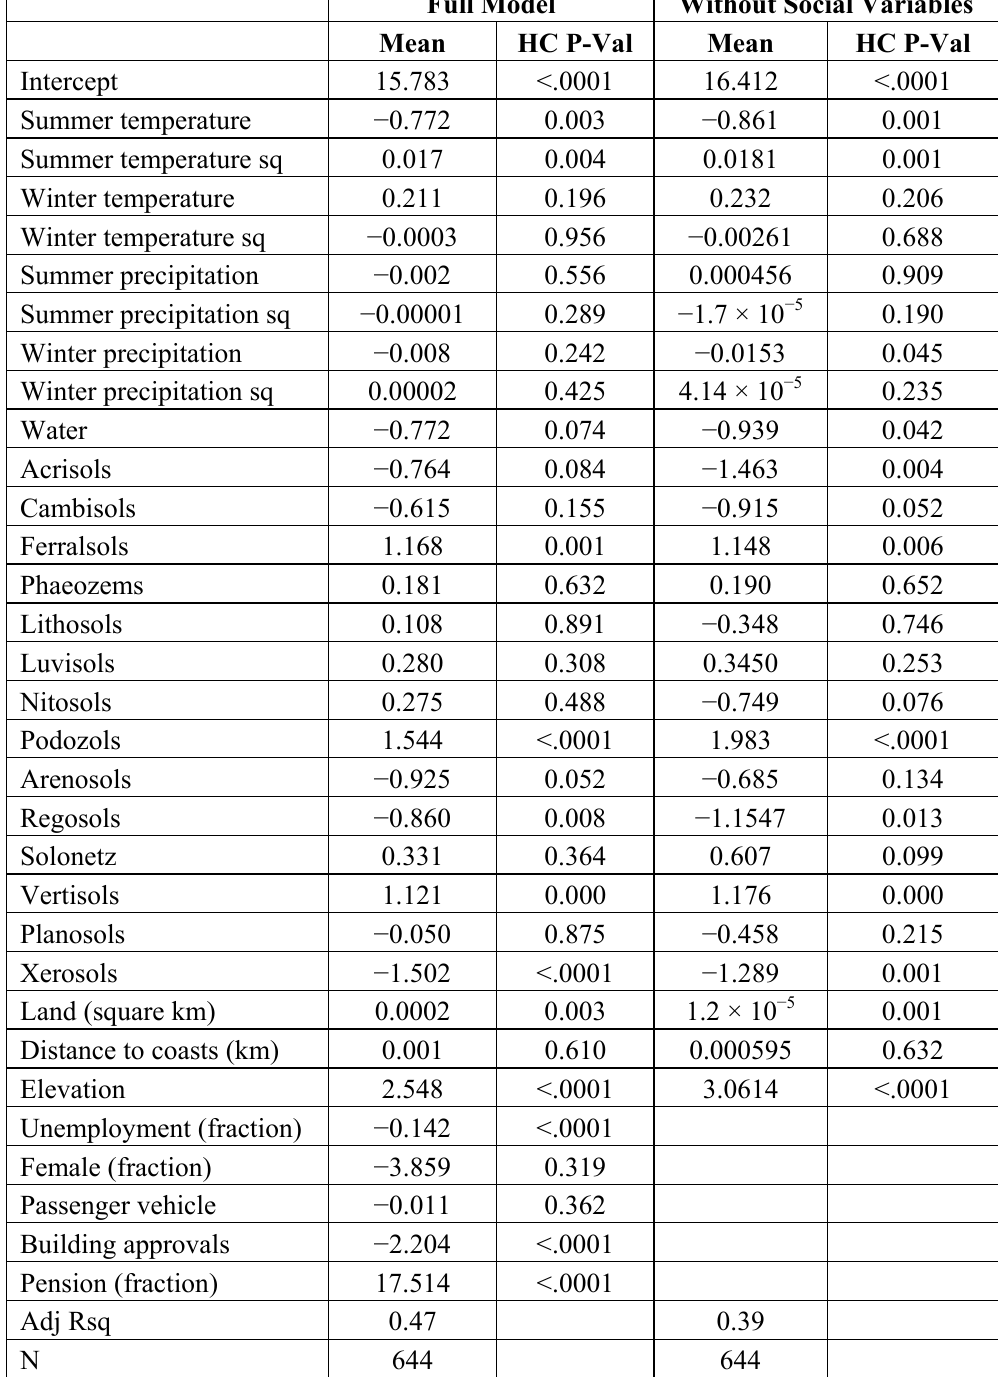
Table 3. The number of beef cattle (in log) per 1,000 rural